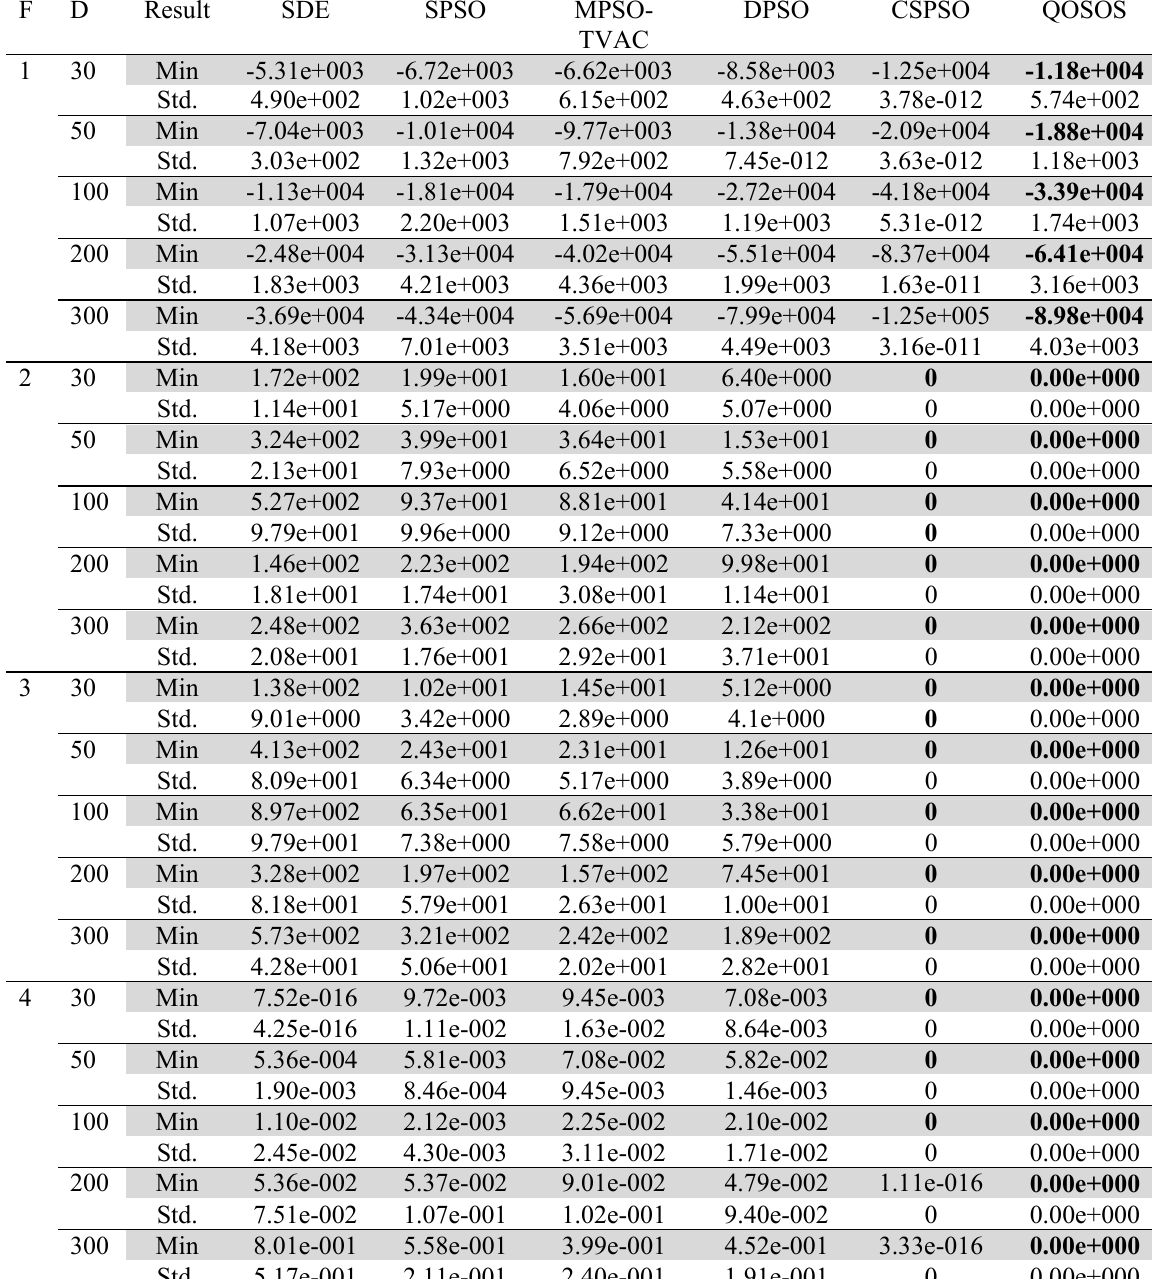
Performance results of SDE, SPSO, MPSO-TVAC, DPSO, CSPSO and QOSOS at dimensions (D) 30, 50, 100, 200 and 300 after reaching D*5000 FEs of four (F1-F4) well known benchmark functions over 20 runs with 40 eco-size. ‘‘Min ’’ and ‘‘std.’’ show the best and standard deviation of the benchmark functions respectively. Boldface represents the best result among the compared